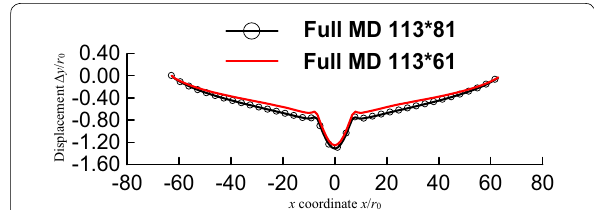
Figure 10 Comparison of displacements of the first layer atoms for different two‑dimensional full MD